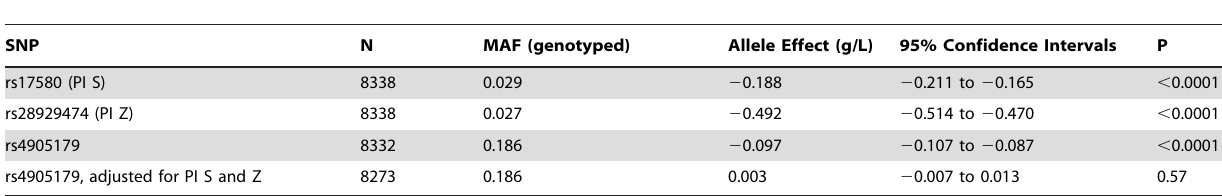
Table 3. Minor allele effects of PI S, PI Z and rs4905179 on AAT serum levels in the Copenhagen City Heart Study.